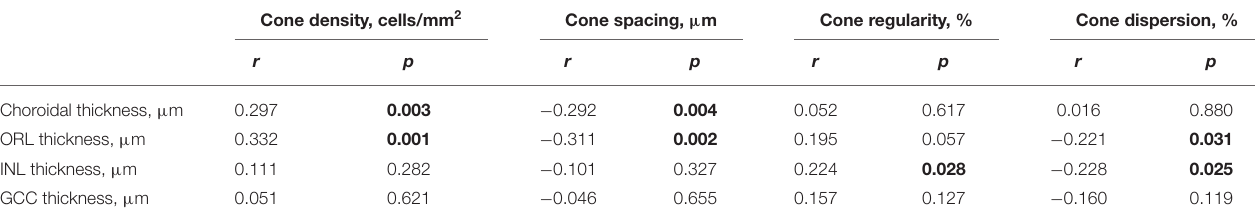
TABLE 3 | Correlations between cone features and the thickness of choroid and retina. Cone density, cells/mm 2 Cone spacing, µ m Cone regularity, %